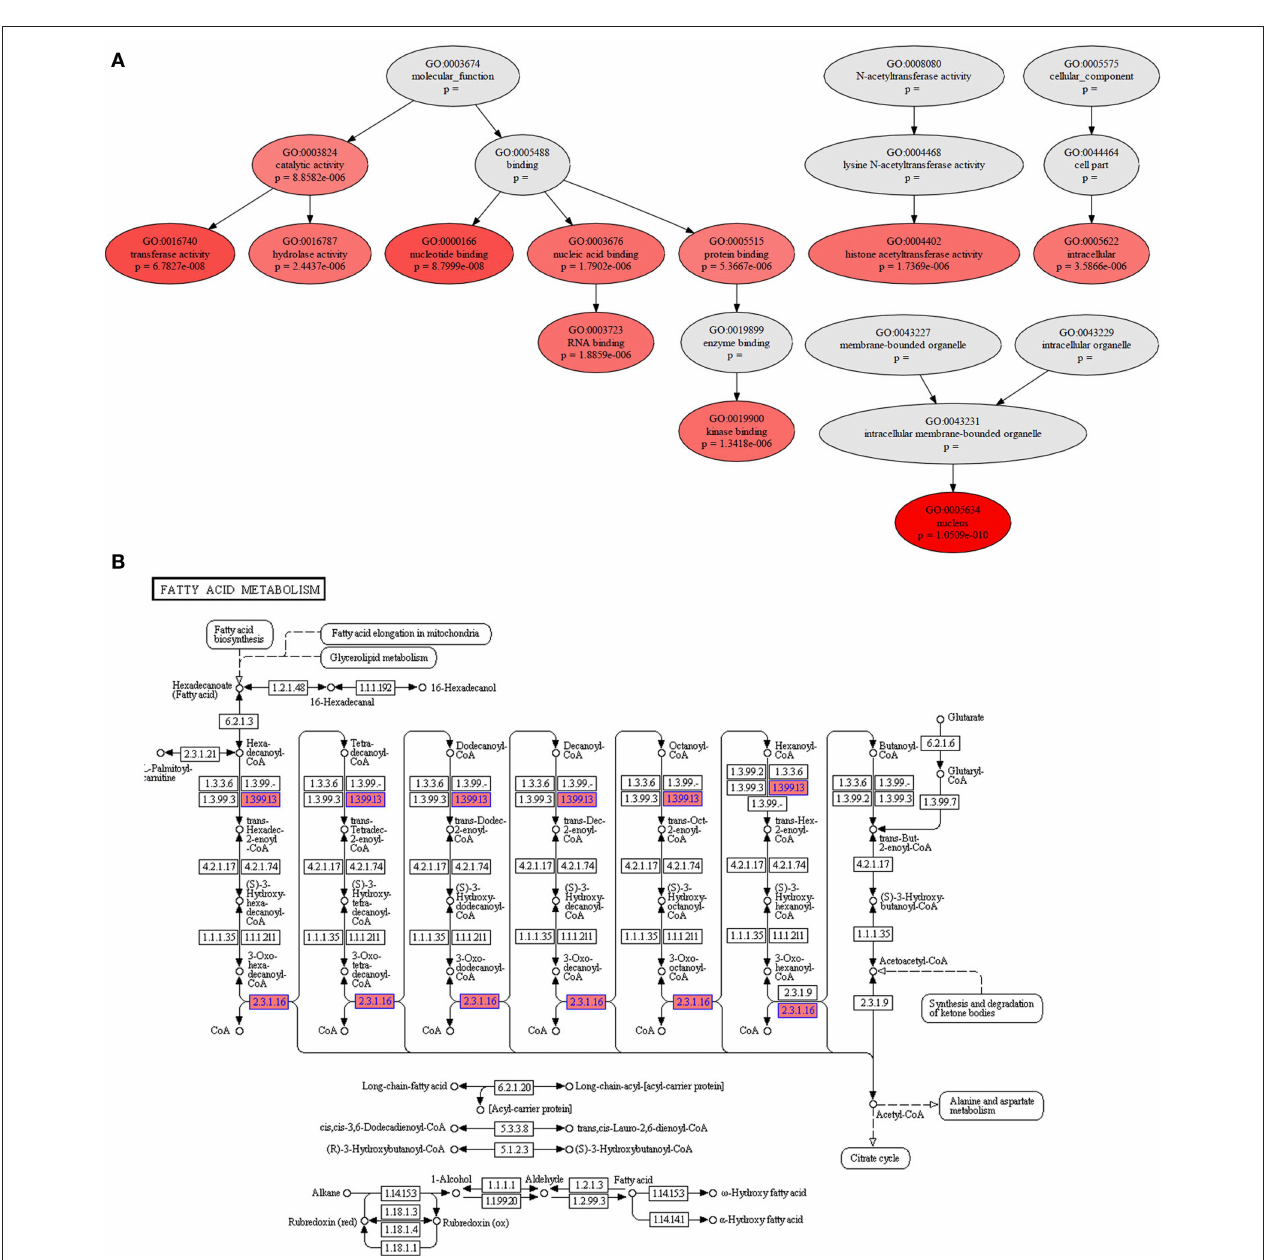
Figure 2 | Two graphical outputs from StrAnger applications. (A) A tree view presenting the relationships among the 10 top GO terms from Table 1 . The ancestor depth has been set at 2. The significance of each GO term is depicted by the accent of the fill color in the respective nodes (here red), that has been selected to map each dataset. (B) Illustration of KEGG pathway “Fatty acid metabolism” from Table 2 , with colored